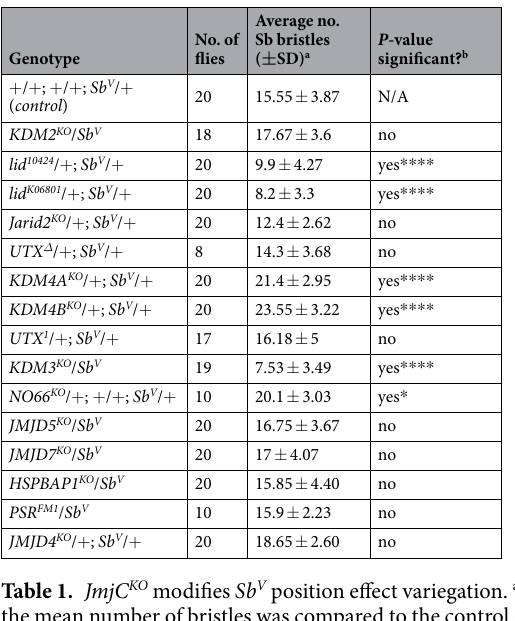
5 Scientific RepoRts | 7: 5240 | DOI:10.1038/s41598-017-05004-w